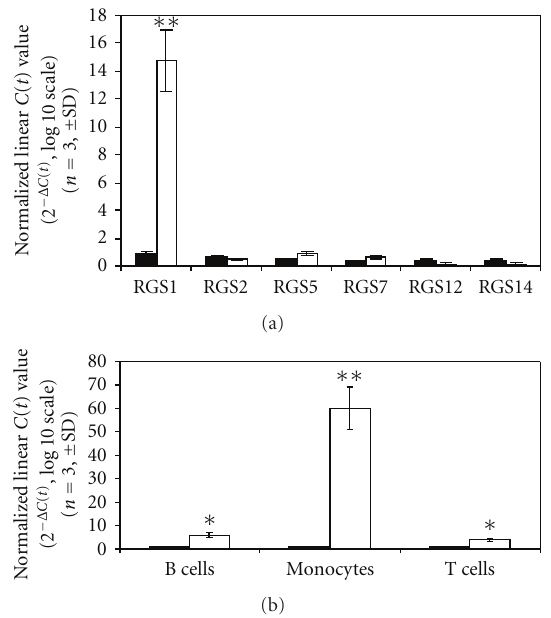
Figure 1: RGS1 expression and cell-type specificity . PBMCs were stimulated with IFN- β (1000IU/mL) for 4 hours (Figure 1(a)). RNA was isolated, and expression of di ff erent RGS family members was determined by RT-PCR as described in Section 2. Results are presented as linearized C ( t ) values ( n = 3, ± SD) normalized to GAPDH. For comparison, samples having background expression were calibrated to 1.0 (black columns). RGS1 was clearly the most predominant RGS family member induced by IFN- β after 4 hours (white columns). Each RGS family member tested is shown on the x -axis. Figure 1(b) shows the IFN- β -dependent expression of RGS1 in three di ff erent primary cell populations (B cells, monocytes, T cells). Data are presented as nonlinearized C ( t ) values normalized to GAPDH (mean ± SD, n = 3). ∗ P < . 05, ∗∗ P < .